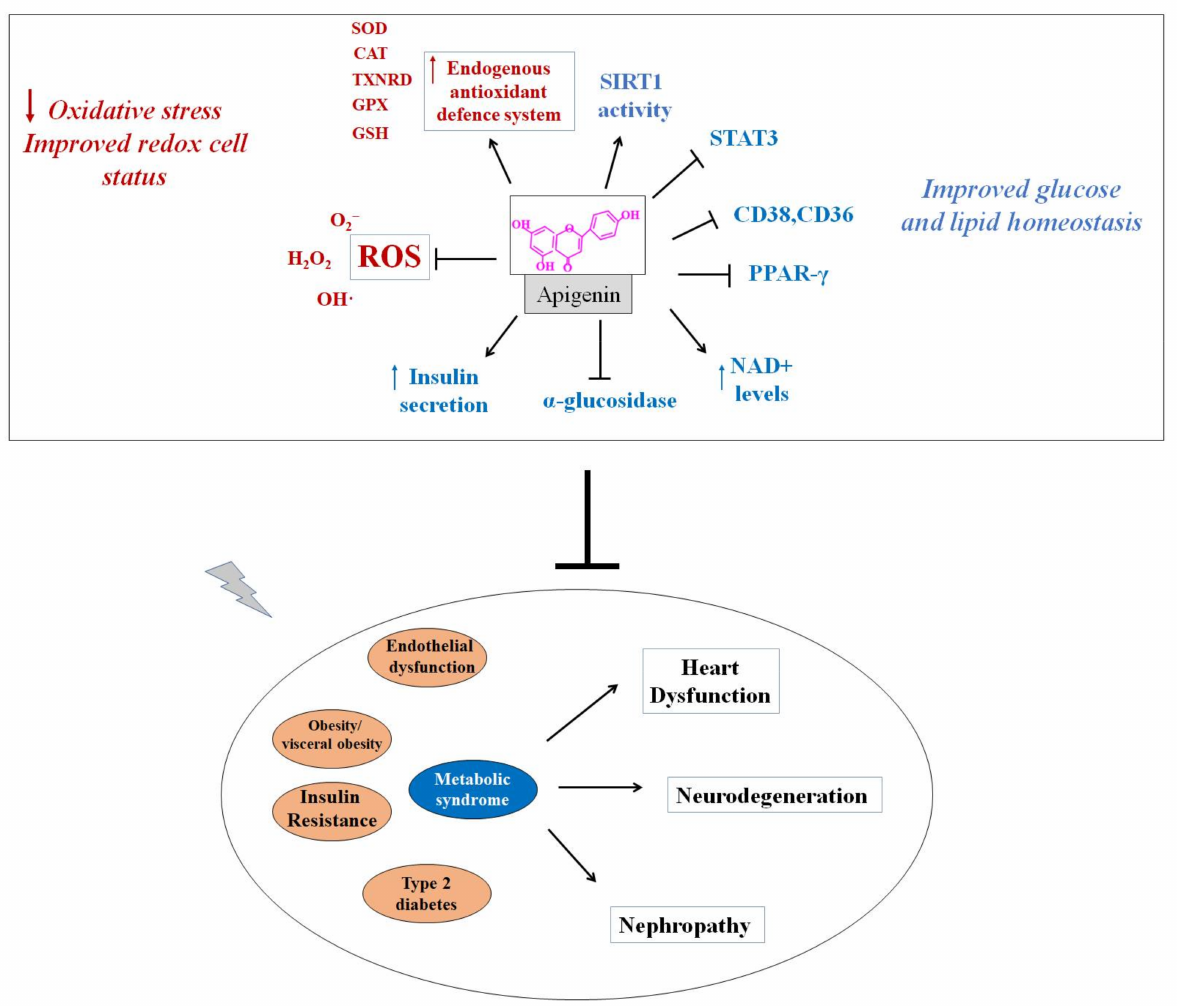
Figure 4. Proposed mechanism of action of apigenin in metabolic syndrome. CAT: catalase; CD36: cluster determinant 36; CD38: cluster of differentiation 38; GPX: glutathione peroxidase; GSH: glutathione; H 2 O 2 : hydrogen peroxide; O 2 − : superoxide anion; OH · : hydroxyl radical; SIRT1: sirtuin-1; SOD: superoxide dismutase; STAT3: signal transducer and activator of transcription 3; TXNRD: thioredoxin